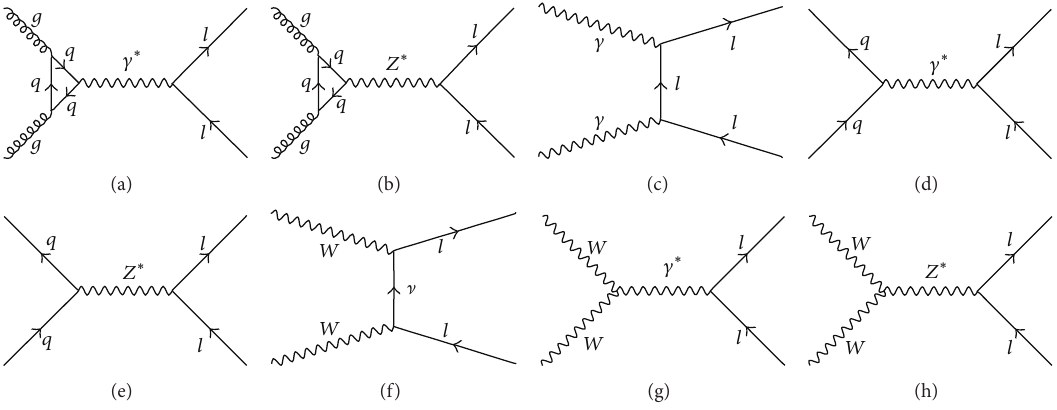
Figure 4: The subprocess Feynman diagrams for dilepton channel.